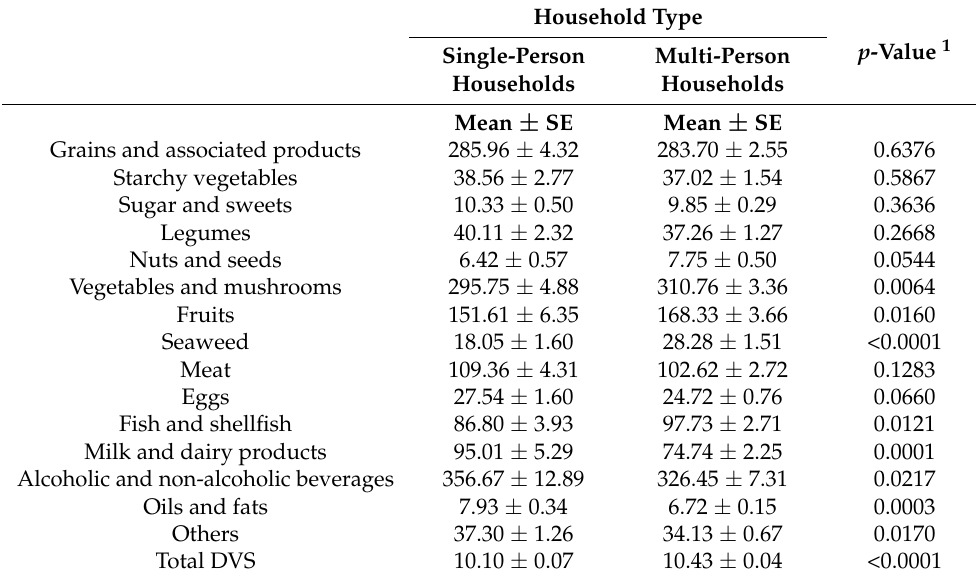
Table 3. Food group consumption and dietary variety among Korean adults according to household type, KNHANES